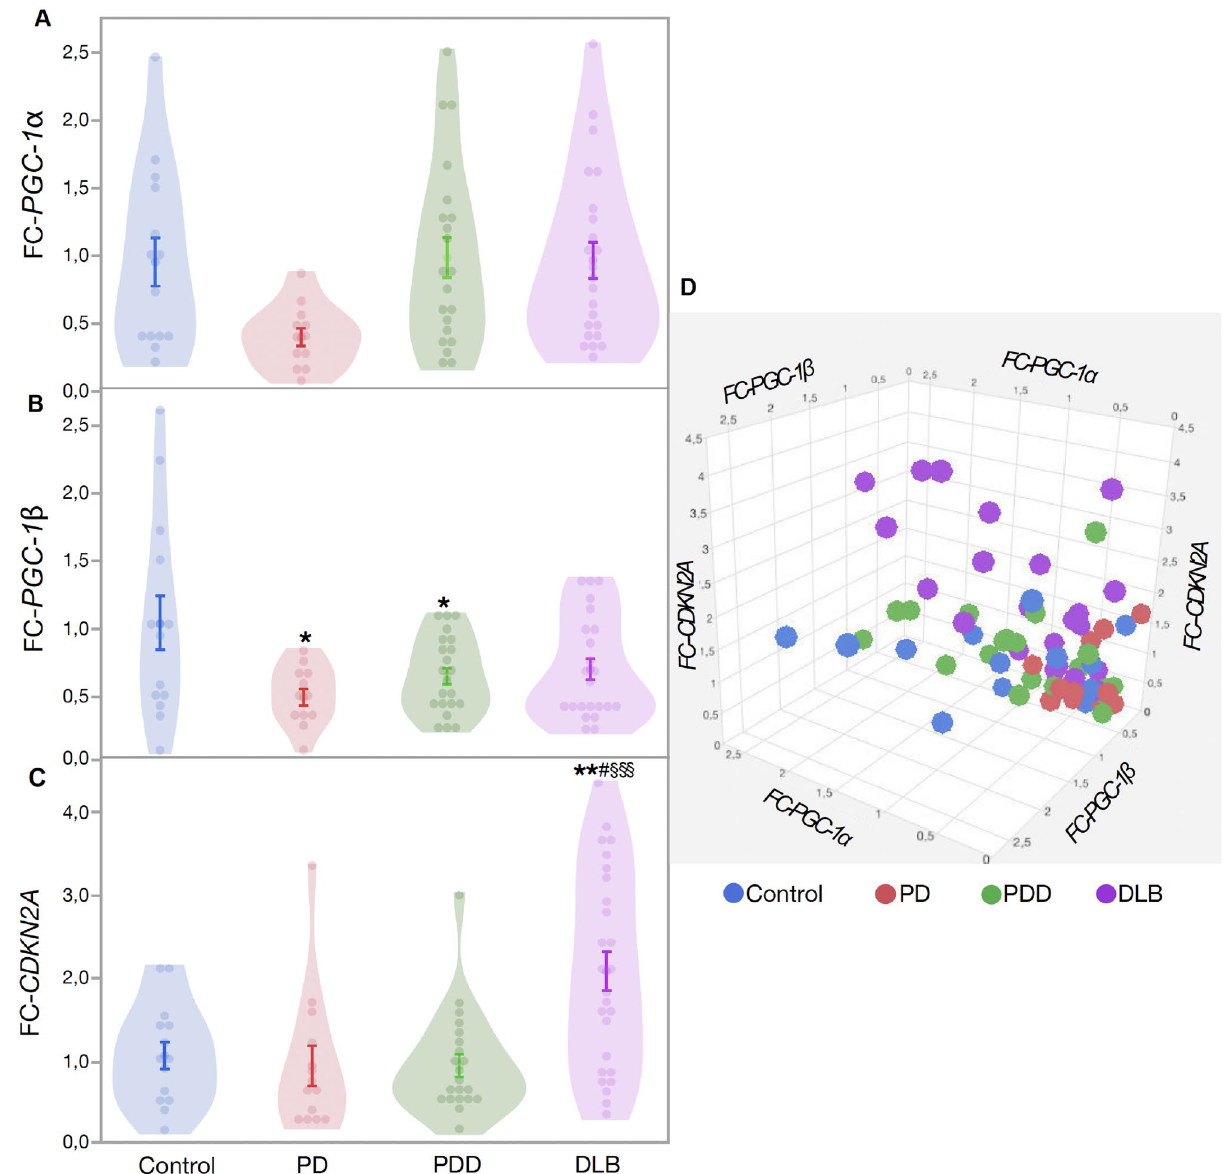
Figure 4. Change in PGC-1α, PGC-1β and CDKN2A gene expression in brain tissues. ( A ) Fold change of PGC-1α in patients compared to controls, ( B ) fold change of PGC-1β in patients compared to controls, ( C ) fold change of CDKN2A in patients compared to controls, ( D ) 3D graph showing the relation between expression of PGC-1α, PGC-1β and CDKN2A in patients and controls. Data are presented as mean ± SE. Controls versus patients p < 0.05 = *, p < 0.005 = **, p < 0.0005 = ***; PD versus PDD/DLB, p < 0.05 = #, p < 0.005 = ##, p < 0.0005 = ###; PDD versus DLB, p < 0.05 = §, p < 0.005 = §§, p < 0.0005 =